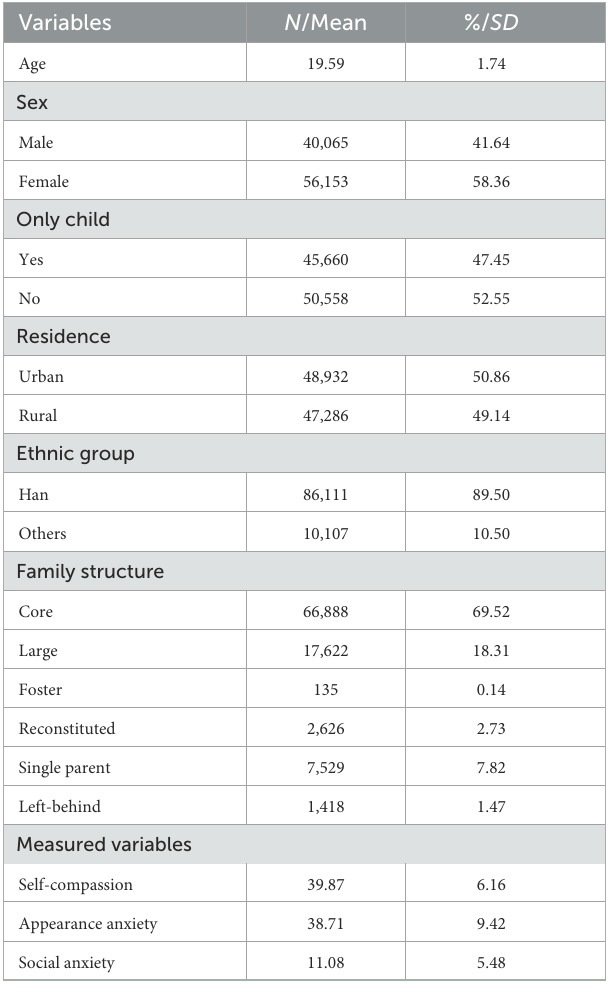
TABLE 1 Socio-demographic characteristics of the study sample ( N =